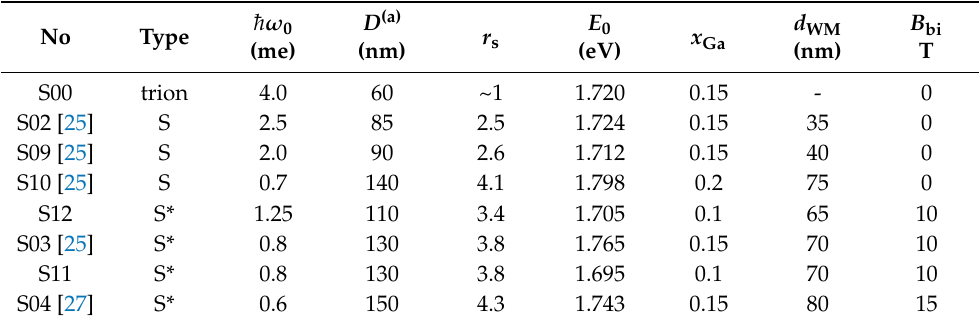
Table 1. Parameters of electronic states of single electron InP/GaInP 2 QDs measured in magneto- PL